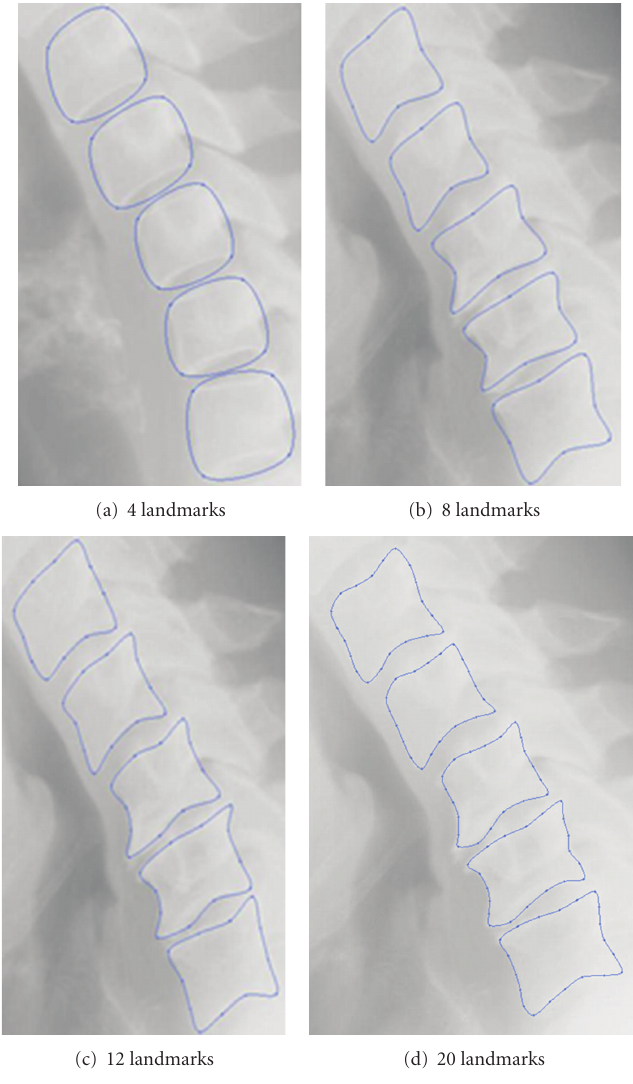
Figure 11: Influence of the number of